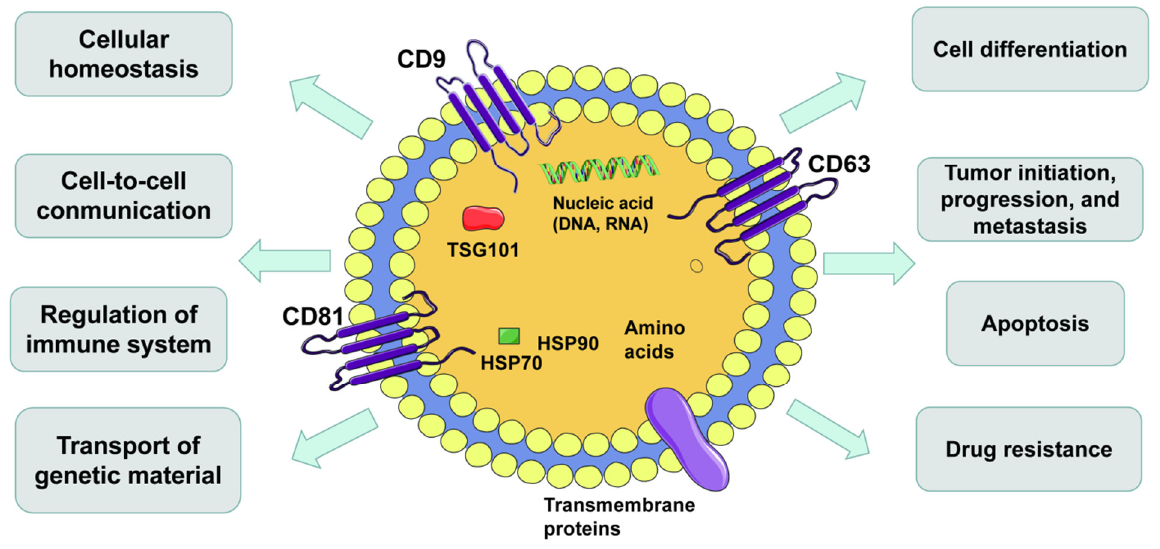
Figure 1. Hallmarks of extracellular vesicles (EVs). EVs are secreted by all kinds of cells and carry DNAs, RNAs, proteins, lipids and metabolites. EVs are important mediators of intercellular communication and affect all aspects of cell biology.